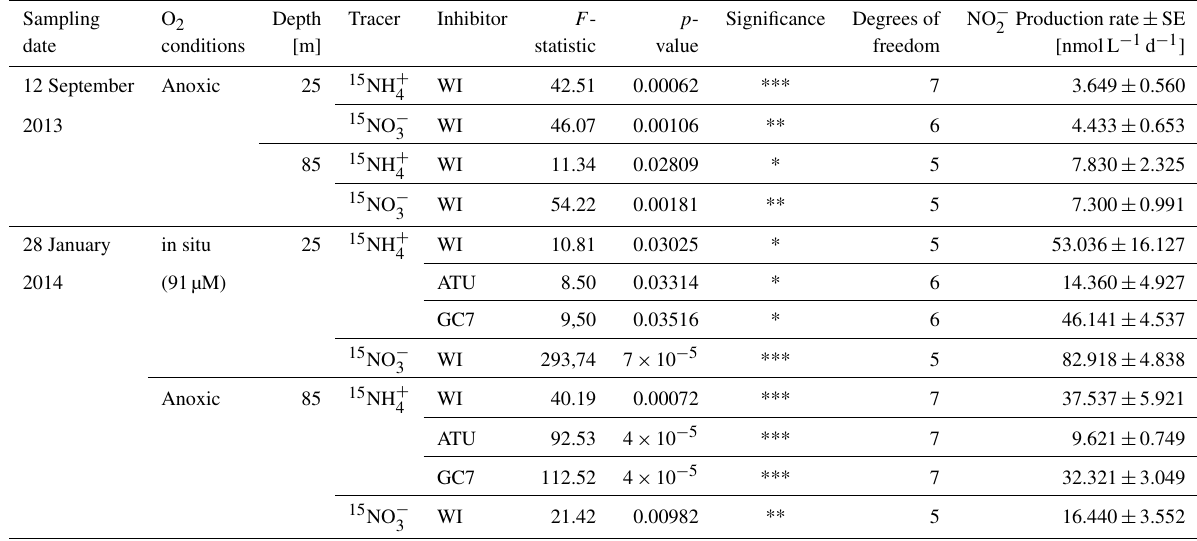
Table 3. Experimental dates, oxygen conditions during the incubations, tested depths, tracers and inhibitors amendments, summary of the Student’s t test used to evaluate the significance of the activity obtained, and nitrite production rates measured as 29 N 2 after chemical conversion.